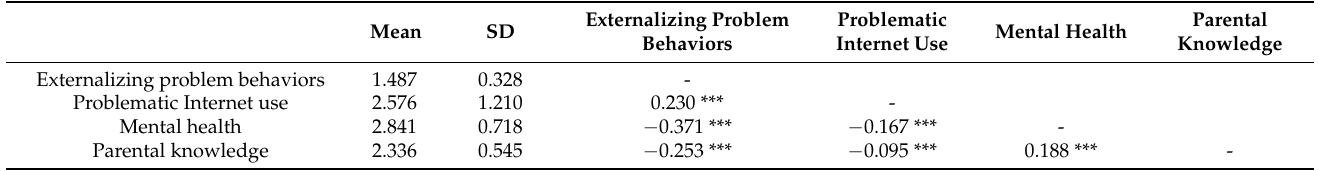
Table 1. Correlation analysis between key variables.